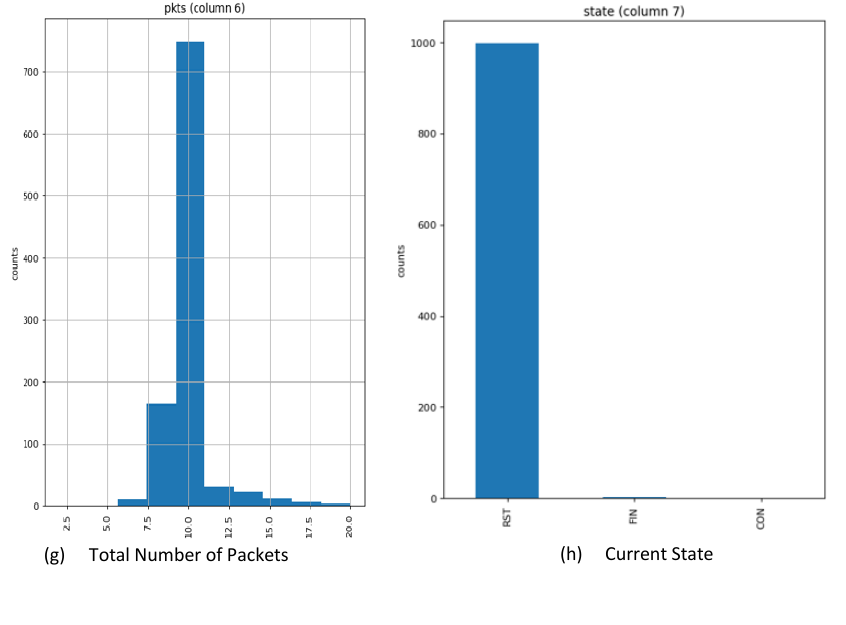
Figure 7. Outliers Detection